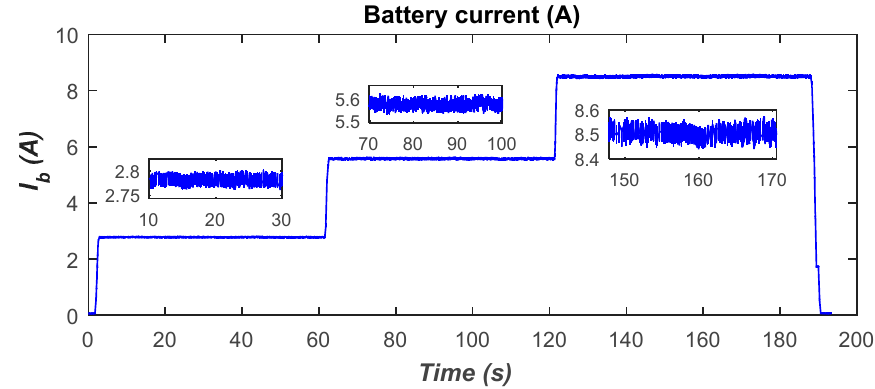
Figure 28. Battery-charging current variations.